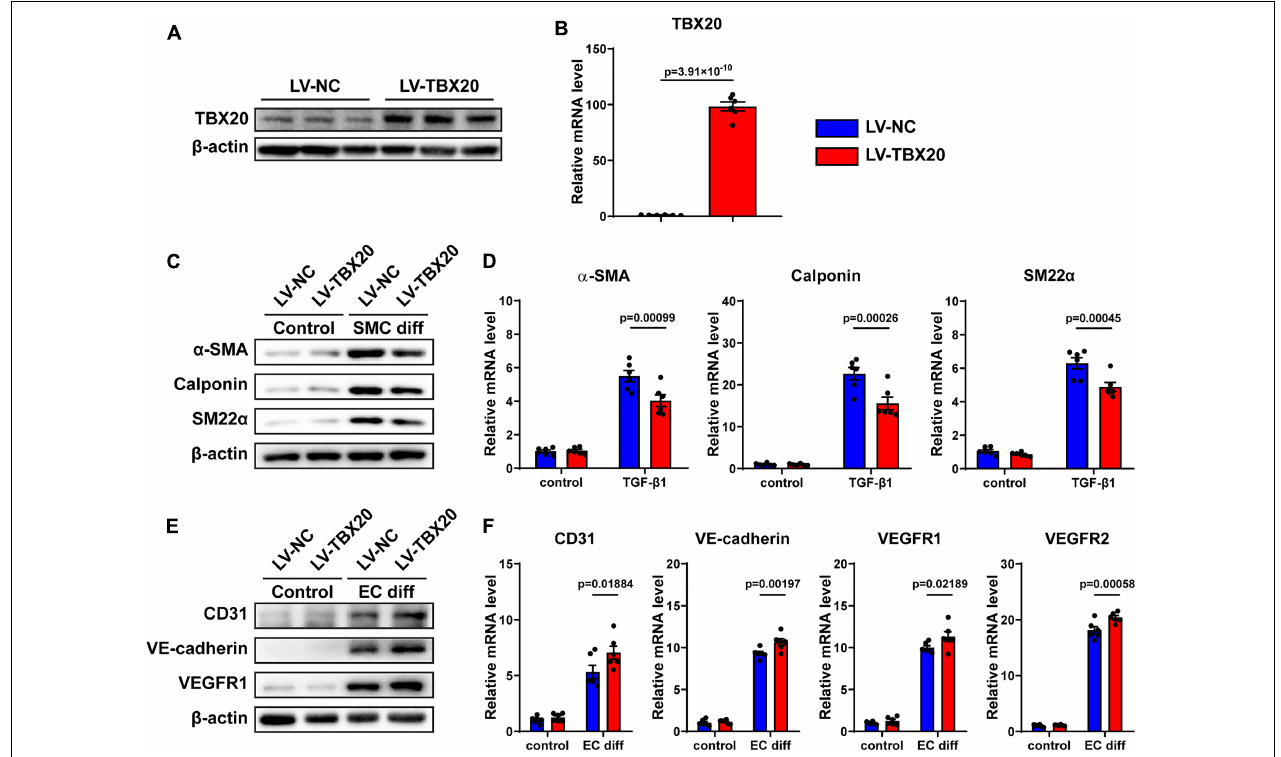
FIGURE 4 | Overexpression of TBX20 suppressed SMC differentiation and promoted EC differentiation. (A,B) TBX20 level was significantly upregulated after LV-TBX20 lentivirus transfection, determined with Western Blot (A) and QPCR (B ). (C,D) Transfection of PVASCs with LV-TBX20 lentivirus suppressed the level of SMC markers as shown by Western Blot (C) and QPCR (D) . (E,F) Transfection of PVASCs with the LV-TBX20 lentivirus promoted the level of EC markers as shown by Western Blot (E) and QPCR (F)